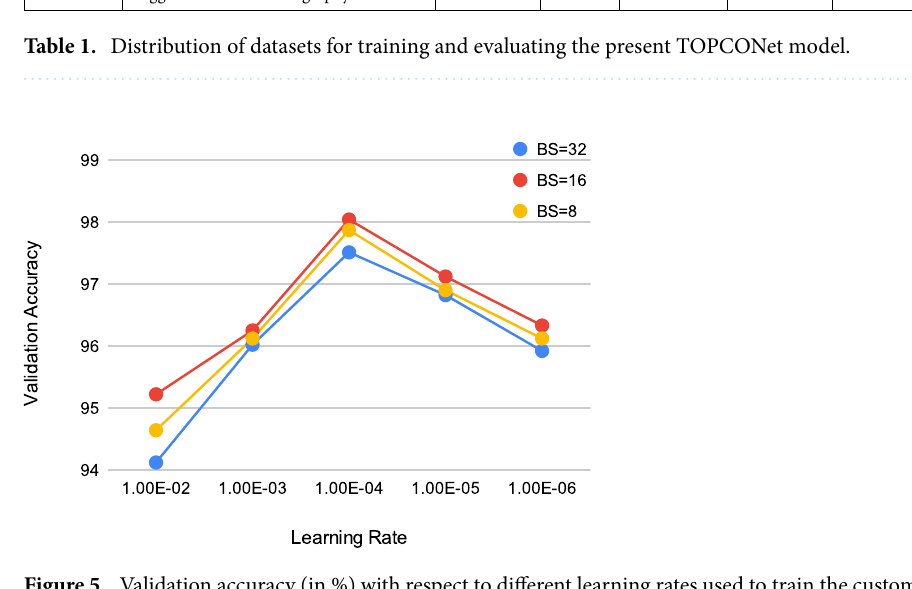
Figure 5. Validation accuracy (in %) with respect to different learning rates used to train the customised CNN